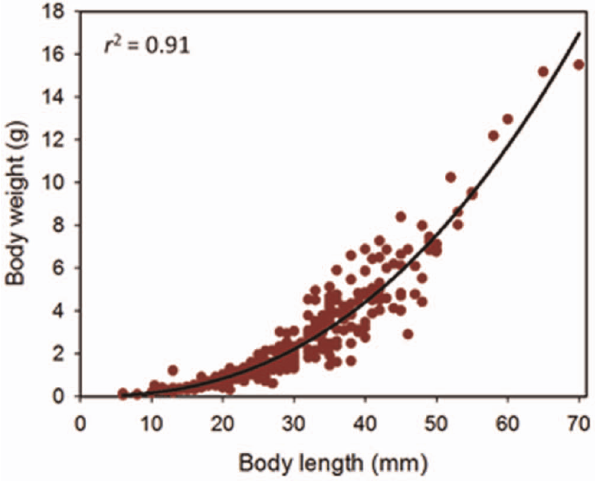
Figure 4. Body length vs body weight of juveniles sandfish. Scatterplot shows relationship (growth curve) of body length with body weight for sandfish juveniles of 6–70 mm in length. Juveniles were drained and blotted dry on a damp cloth for 30 sec before being measured and weighed.